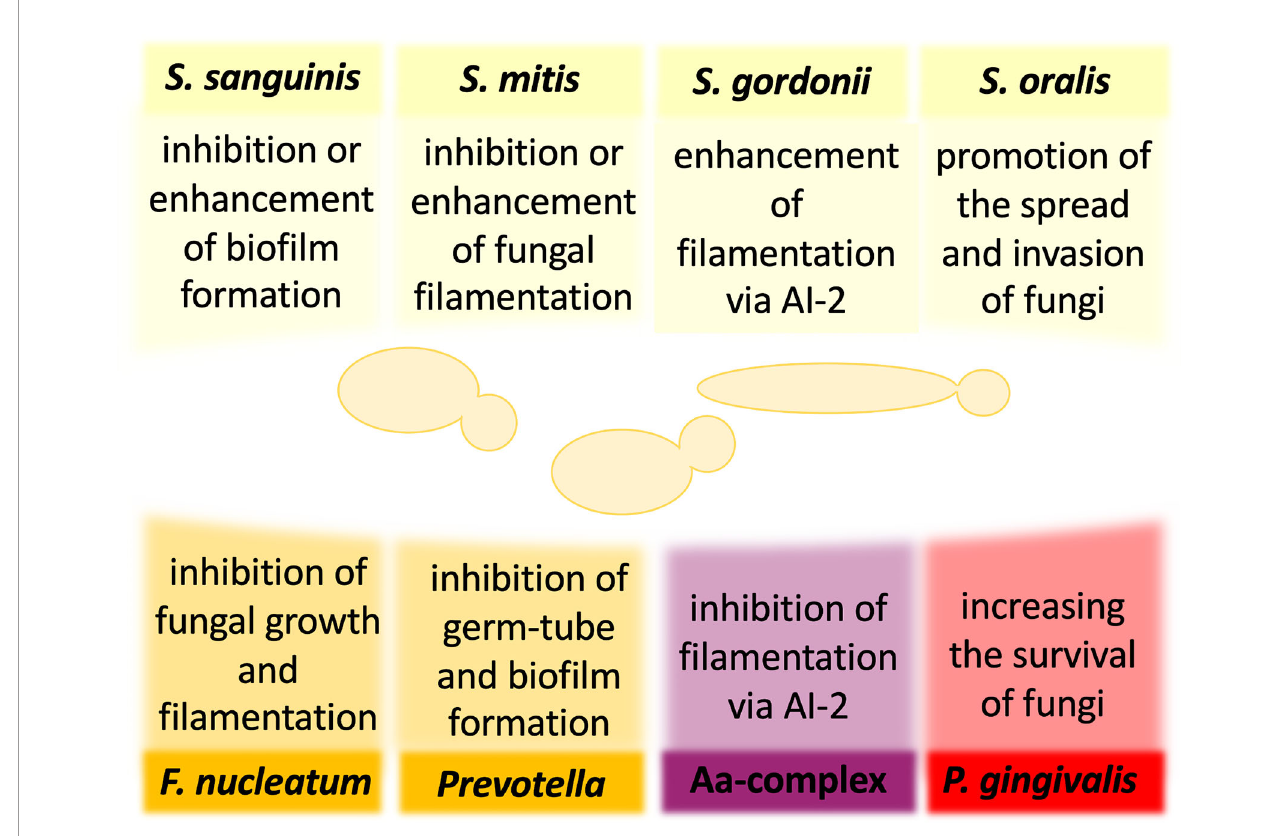
FIGURE 1 | The in fl uence of oral bacteria on the virulence and pathogenicity of Candida albicans . The interactions of C. albicans and oral bacteria occur through many mechanisms and may result in either reduction or enhancement of fungal virulence. For some bacteria, the published preliminary analyses have not yet determined unequivocally the nature of the in fl uence of bacteria on the development of mixed infection with C. albicans. AI-2, autoinducer 2; Aa, Aggregatibacter